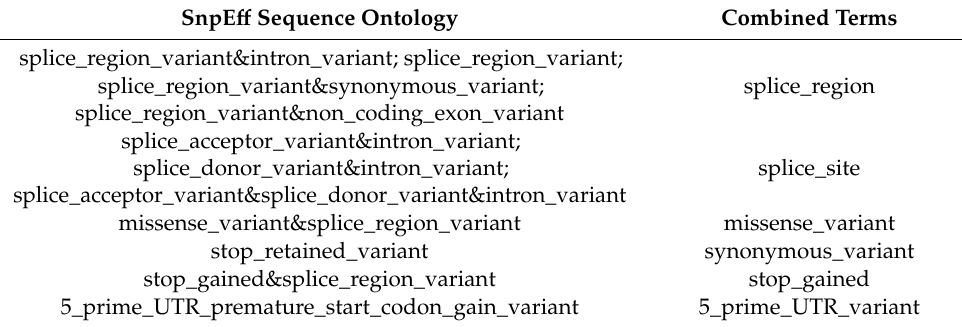
Table 4. Definitions of combined sequence ontology terms used in this study. SnpE ff Sequence